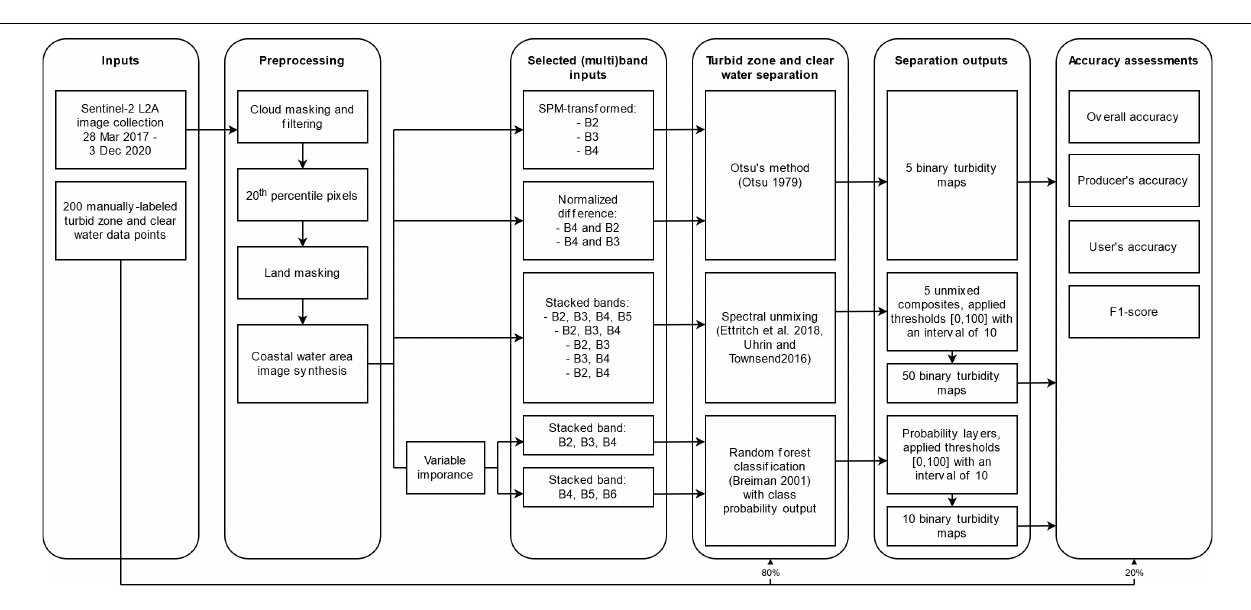
FIGURE 2 | Sentinel-2 L2A water-leaving reflectance (R hown ) spectral profile of the TZ and CW training data in the three study regions: (A) Guinea-Bissau, (B) Tunisia, and (C) Madagascar.